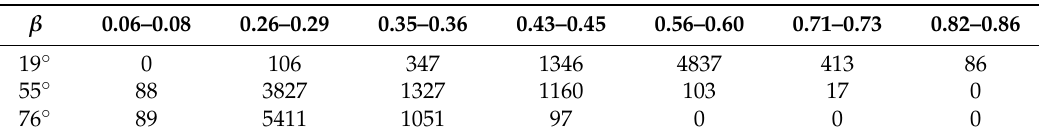
Table 4. Number of pixels for seven sunlit fraction ( α S ) subsets (in columns) for the three scatter angles β used in the